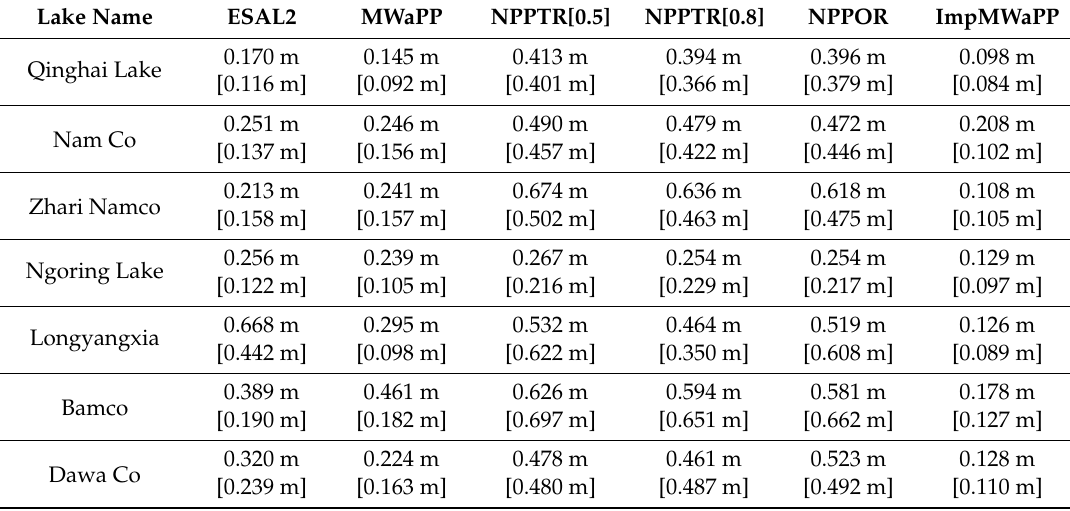
Table 5. Means and medians of track standard deviations derived by the different retrackers over the seven